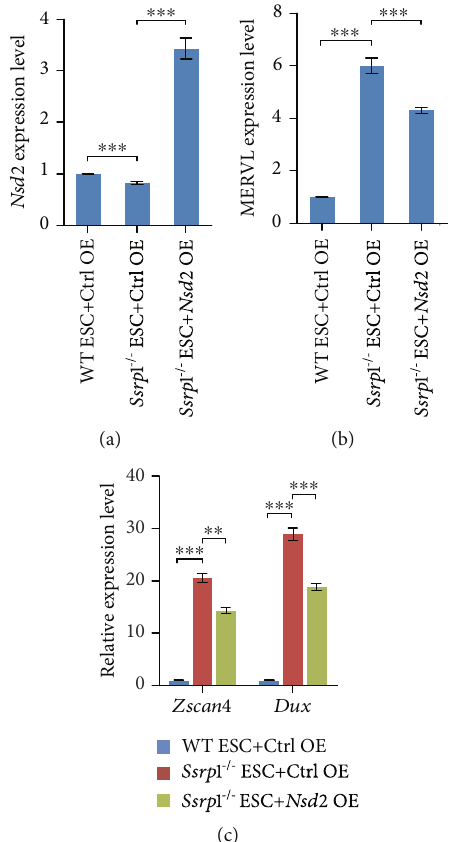
Figure 3: Nsd2 overexpression rescues the expression of MERVL and 2-cell genes. (a) qPCR analysis of Nsd2 expression after overexpression of Nsd2 in Ssrp1 -/- ESC. The results were shown as mean ± s : e : m : , n = 3 biologically independent replicates and normalized to Gapdh . (b) qPCR analysis of the expression of MERVL after overexpression of Nsd2 in Ssrp1 -/- ESC. Mean ± s : e : m : , n = 3 . (c) qPCR analysis of the expression of 2-cell marker genes Zscan4 and Dux after overexpression of Nsd2 in Ssrp1 -/- ESC. Ctrl: control; OE: overexpression; mean ± s : e : m : , n = 3 ; ∗∗ p < 0 : 01 ; ∗∗∗ p < 0 : 001 .